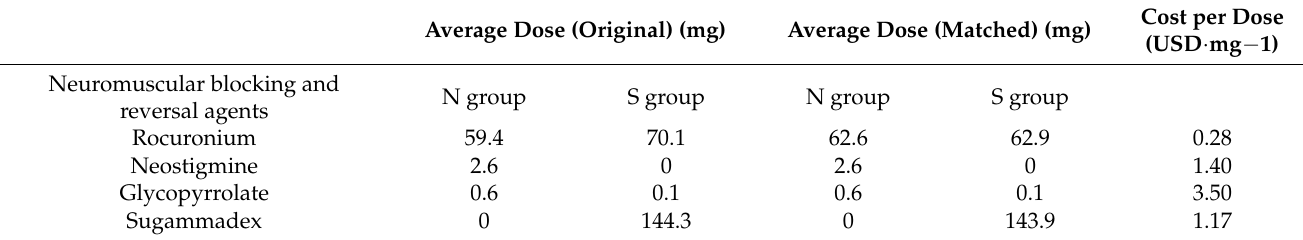
Table 2. Drug doses and costs for cost-effectiveness analyses.